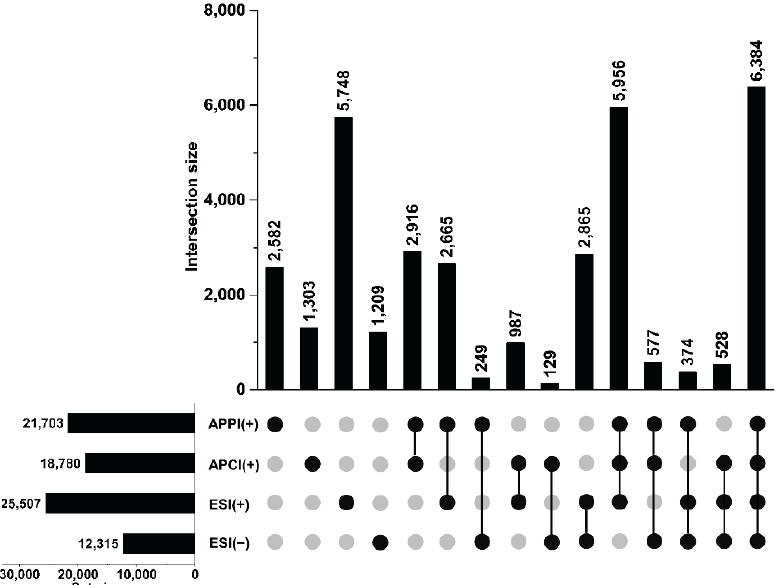
Figure 6. Set-size bar plot on the left displays the numbers of unique formulas detected by the individual ionization techniques. The UpSet plot shows the intersection of detected formulas, Energies 2021 , 14 , x FOR PEER REVIEW gained by using a combination of complementary ionization techniques, as depicted below.